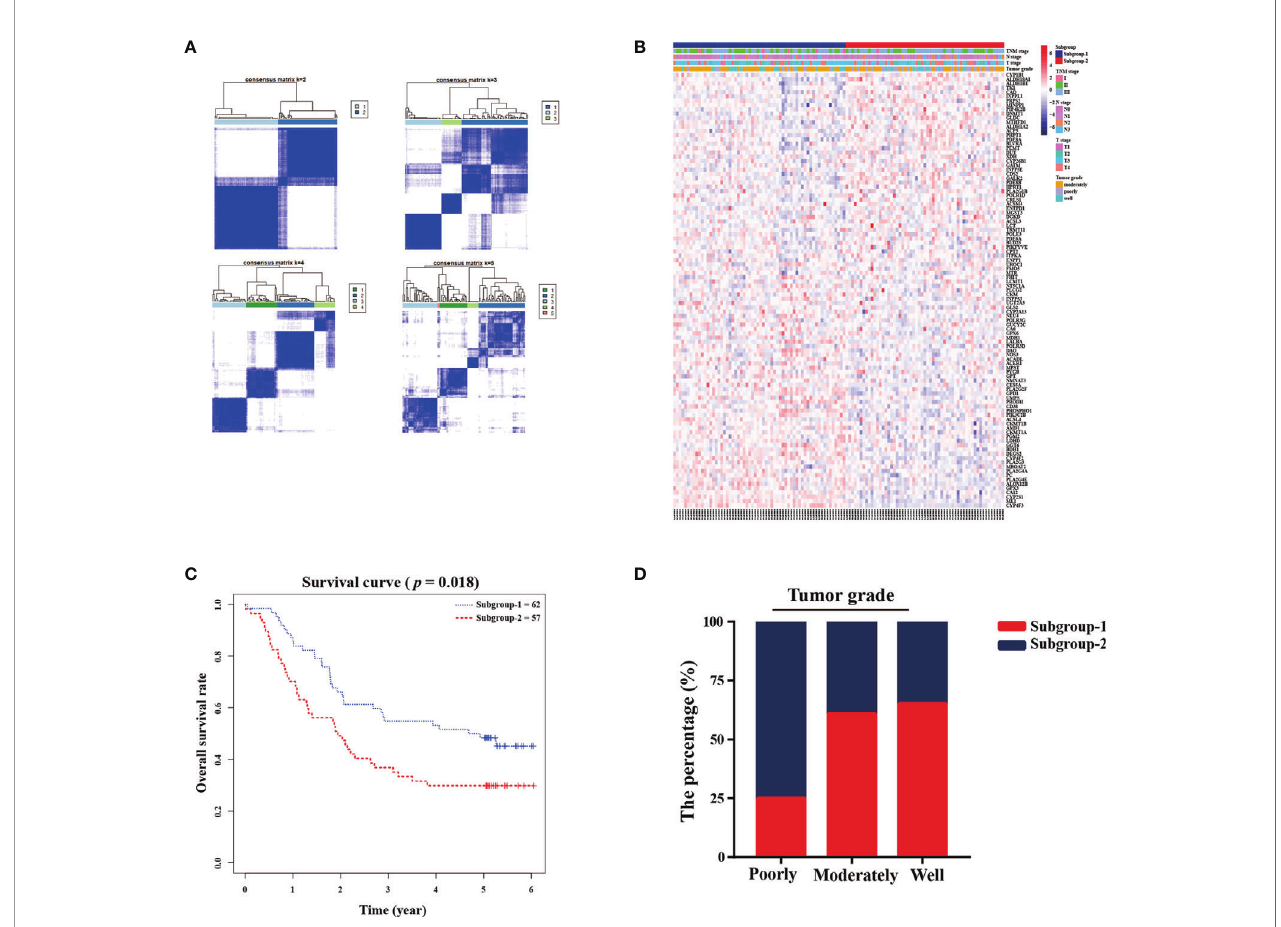
FIGURE 1 | Metabolic-related prognosis gene sets were associated with tumor grade and overall survival. (A) Consensus clustering matrix of 119 ESCC samples for k=2 to k=5. (B) Heatmap and clinicopathologic features of the two subgroups de fi ned by the metabolic-related gene sets. (C) Kaplan-Meier survival analysis for the two subgroups. (D) The percentage of two subgroups in tumor